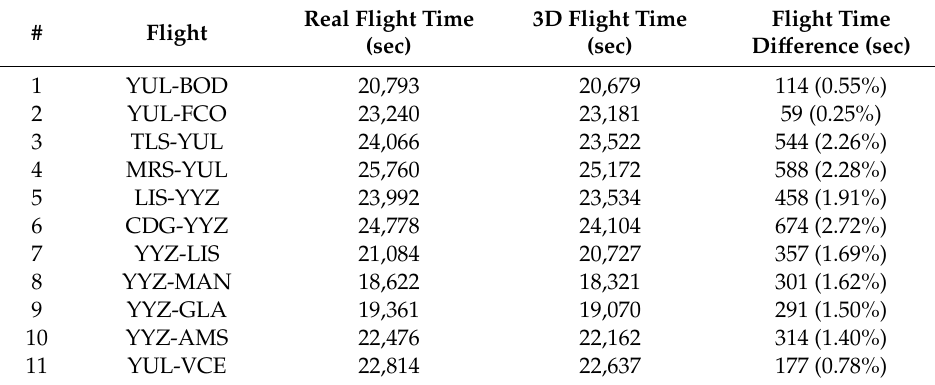
Table 5. Flight time comparison between real flights and the optimized 3D